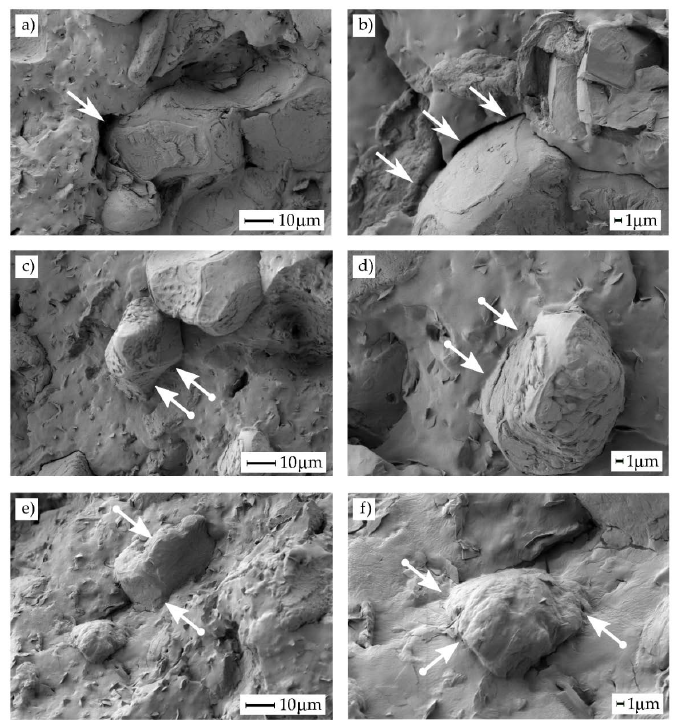
Figure 2. Field emission scanning electron microscopy (FESEM) images at 1000 × (left side) and 2500 × (right side) corresponding to PHBH-ASF composite with 30 wt % ASF with different OLA content, ( a ) & ( b ) 0 phr OLA, ( c ) & ( d ) 10 phr OLA, ( e ) & ( f ) 20 phr